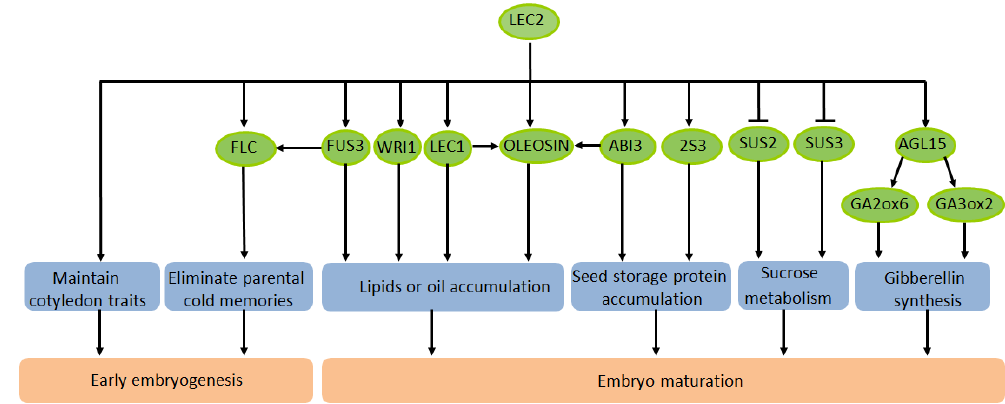
Figure 1. Schematic diagram of the transcription factor LEC2 regulating seed development of A. thaliana .